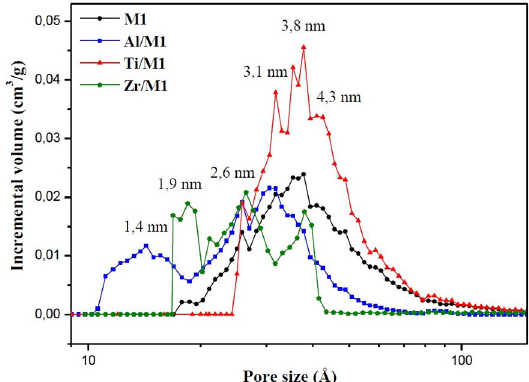
Figure 5. Pore distribution curves of the samples M1, Al/M1, Ti/M1 and Zr/M1.